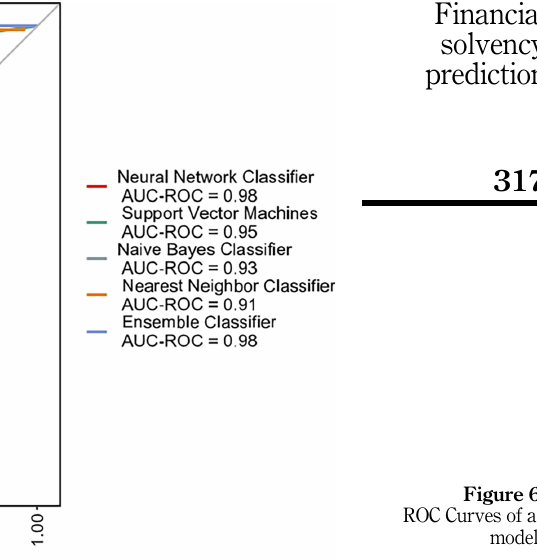
Figure 6. ROC Curves of